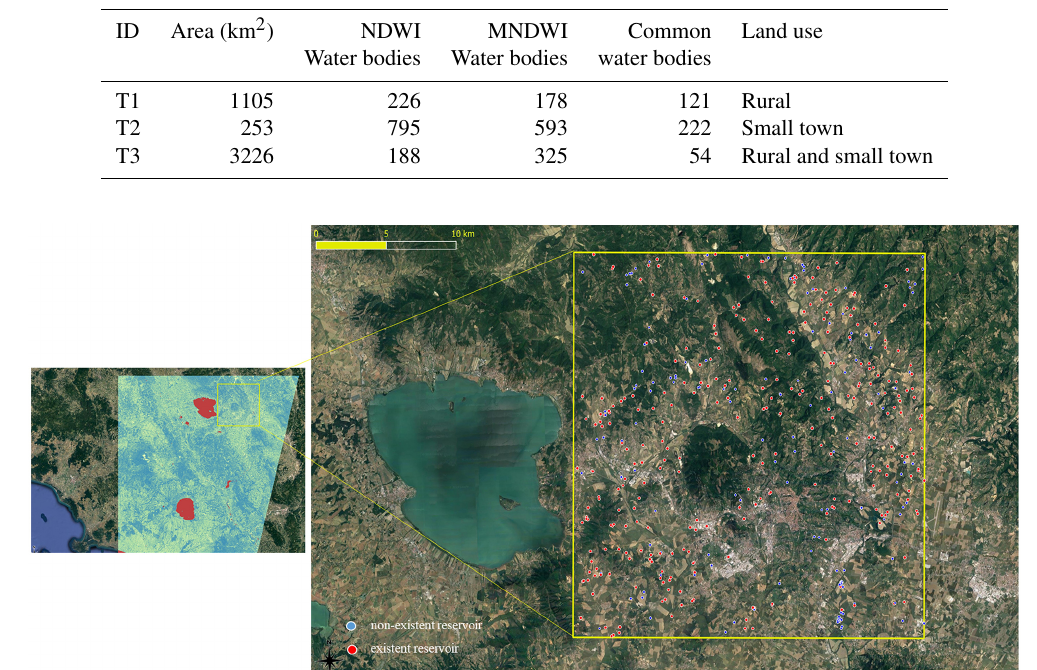
Table 6. Performance of WI on different test areas.